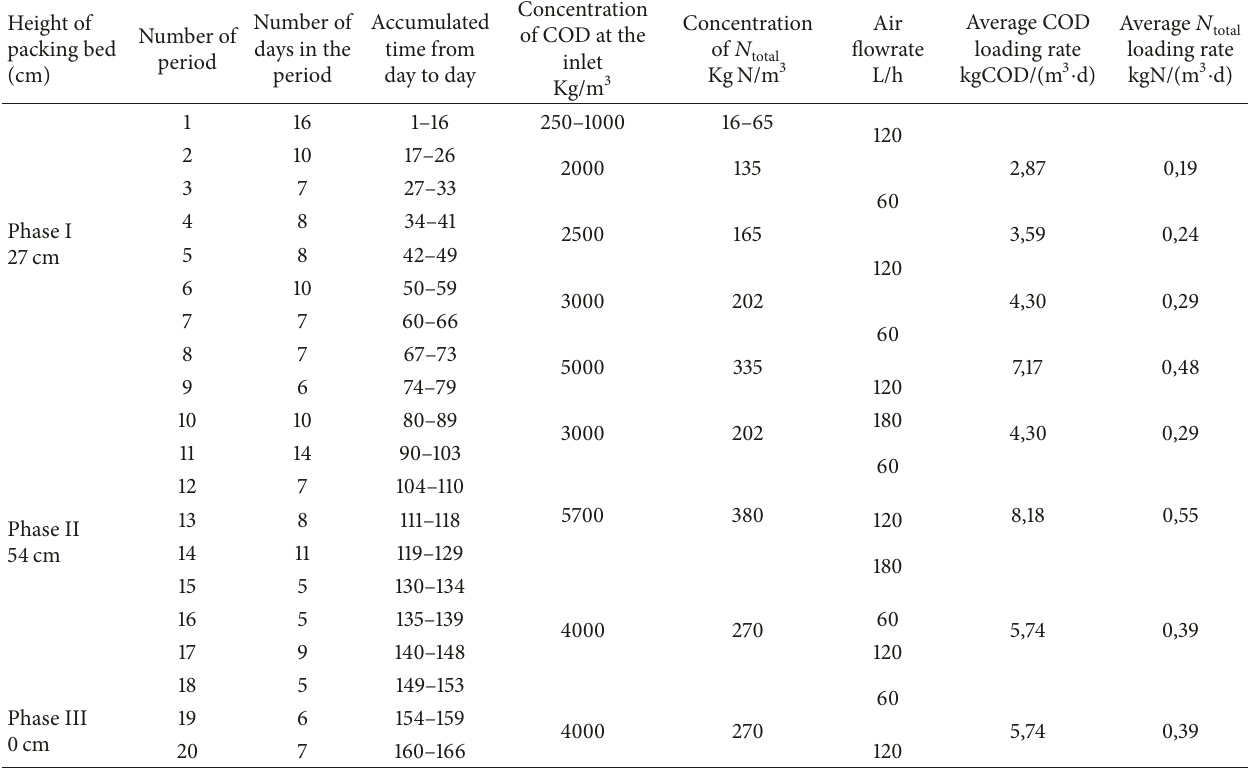
Table 2: Operational conditions of the